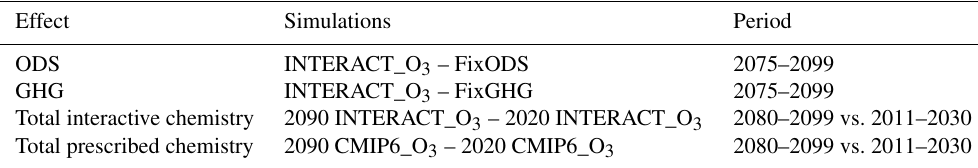
Table 2. Separation of the different effects investigated in this study. The first column gives the effect that is extracted, the second column lists the ensembles that are subtracted to extract an effect, and the third column gives the periods over which the differences are